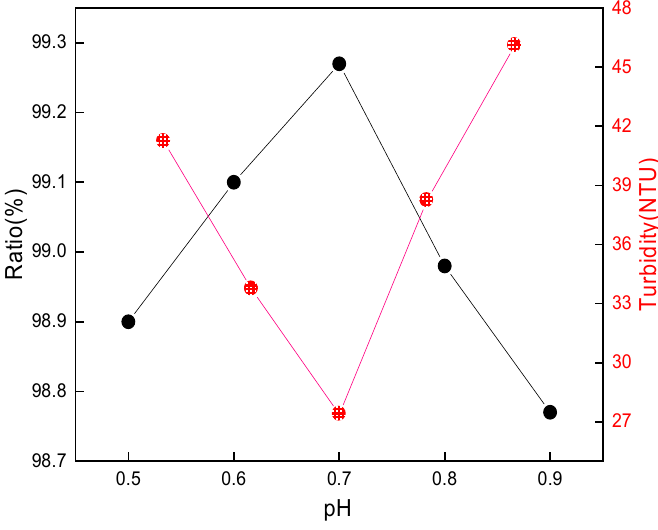
Figure 7. Effect of pH on the turbidity removal ratio. The chemical formula of PAFC shows that the substance is a multimer with aluminum and iron ions as the central ions and hydroxide and chloride ions as the ligands, and due to the different values of m and n, it is a complex mixture of